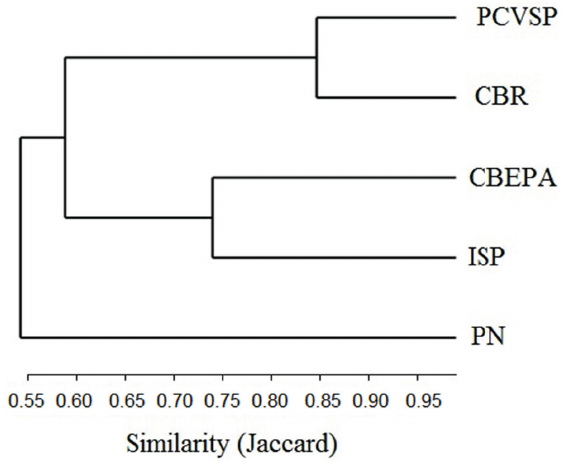
Figure 4 - Cluster analysis (Jaccard) related to the lizard species richness in the fi ve sampled sandy coastal plains remnants on the coast of espírito Santo state, Brazil. ISP: Itaúnas State Park; CBEPA: Conceição da Barra Environmental Protection Area; CBR: Comboios Biological Reserve; PCVSP: Paulo Cesar Vinha State Park; PN: Praia das